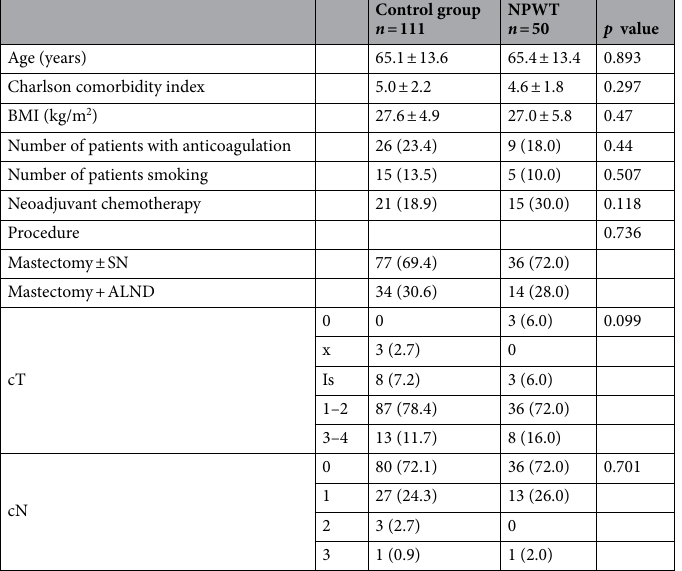
Table 1. Patient and baseline characteristics. Continuous variables are presented as means ± SD. Categorical variables in absolute numbers (%). SN = sentinel node. cT0 = benign tumors/prophylactic. Is = in situ.